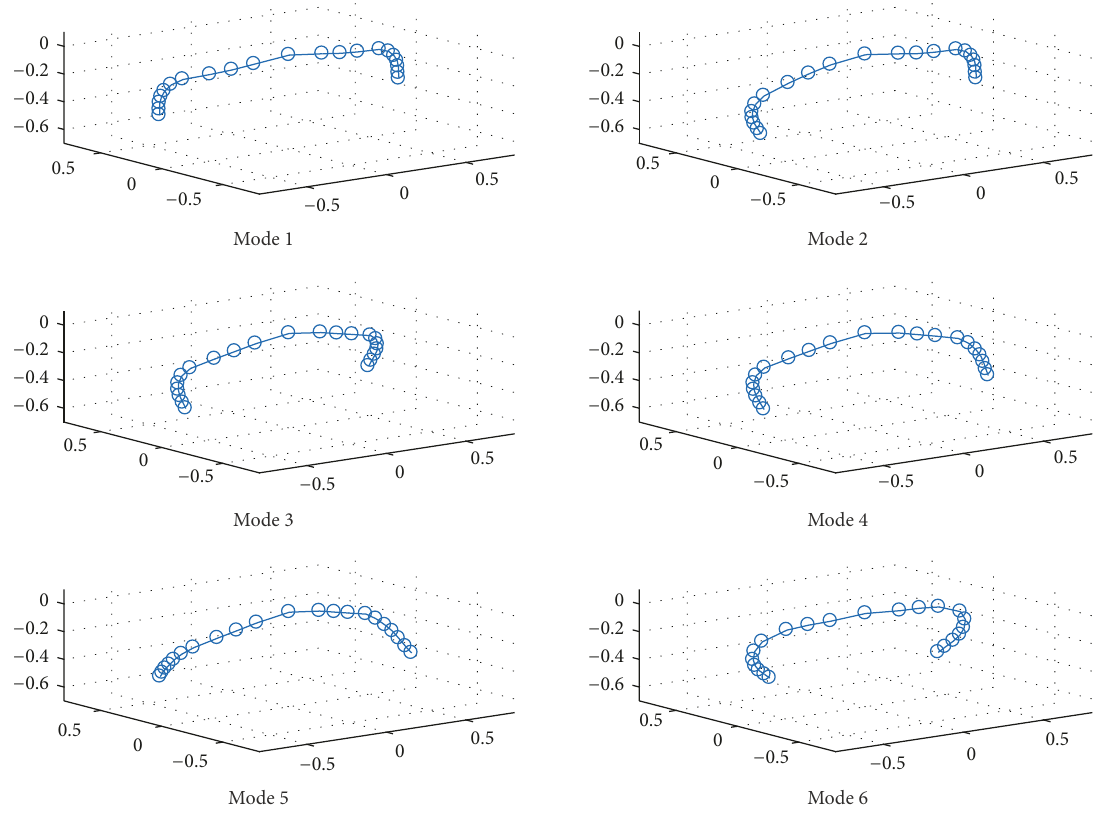
Figure 6: Modal shapes of the composite landing gear.